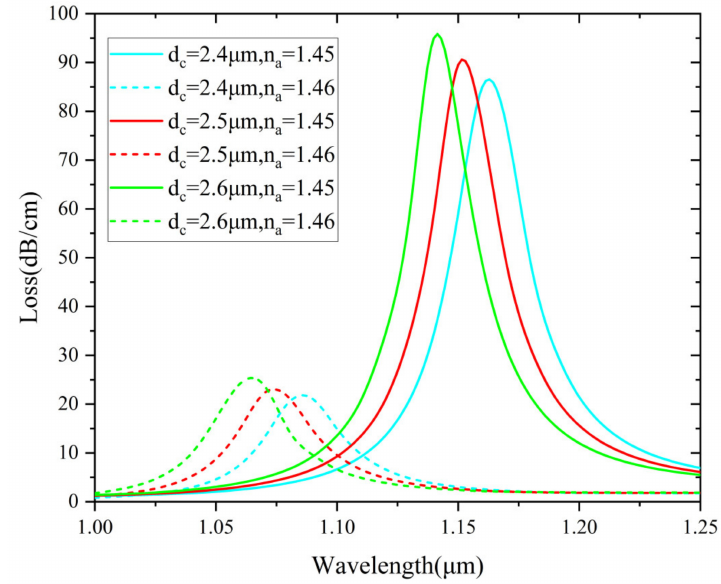
Figure 7. Loss spectra (n a = 1.45 and 1.46) for different d c of 2.4, 2.5 and 2.6 µ m.